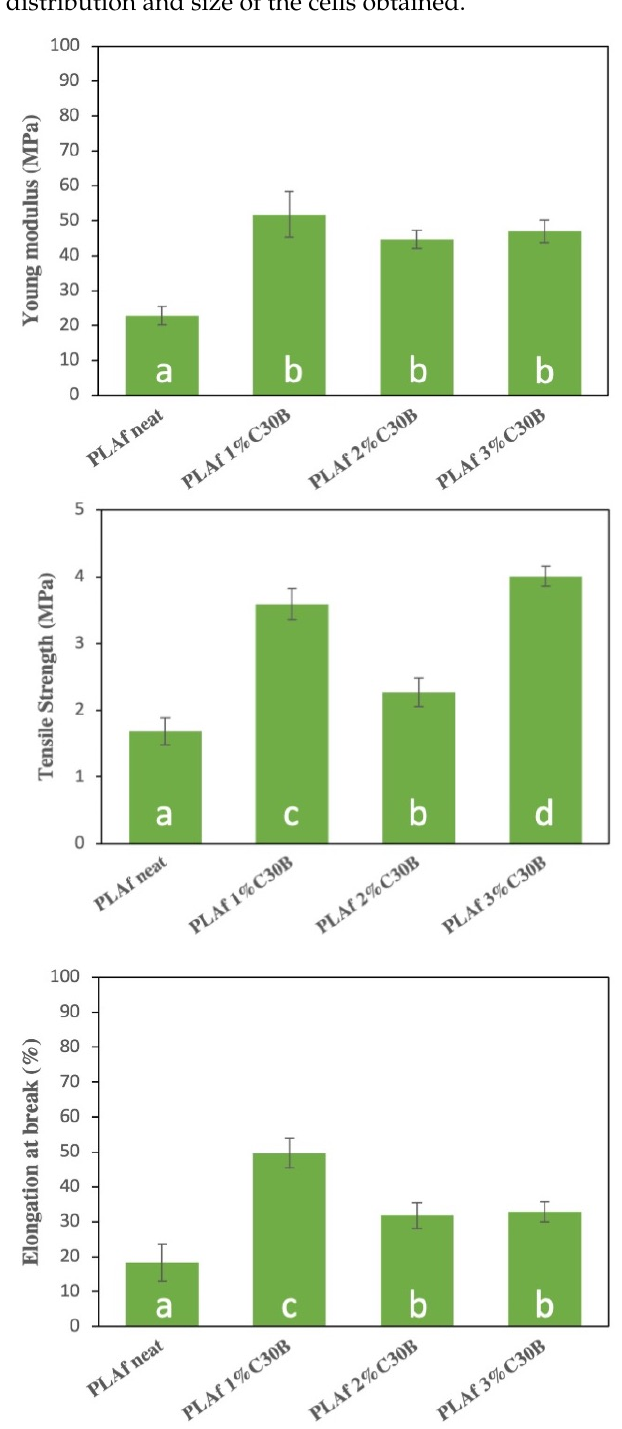
Figure 11. Mechanical properties of PLA and PLA bionanocomposite foams obtained from tensile test measurements. a, b Different superscripts within the same graph indicate significant differences between formulations ( p < 0.05).